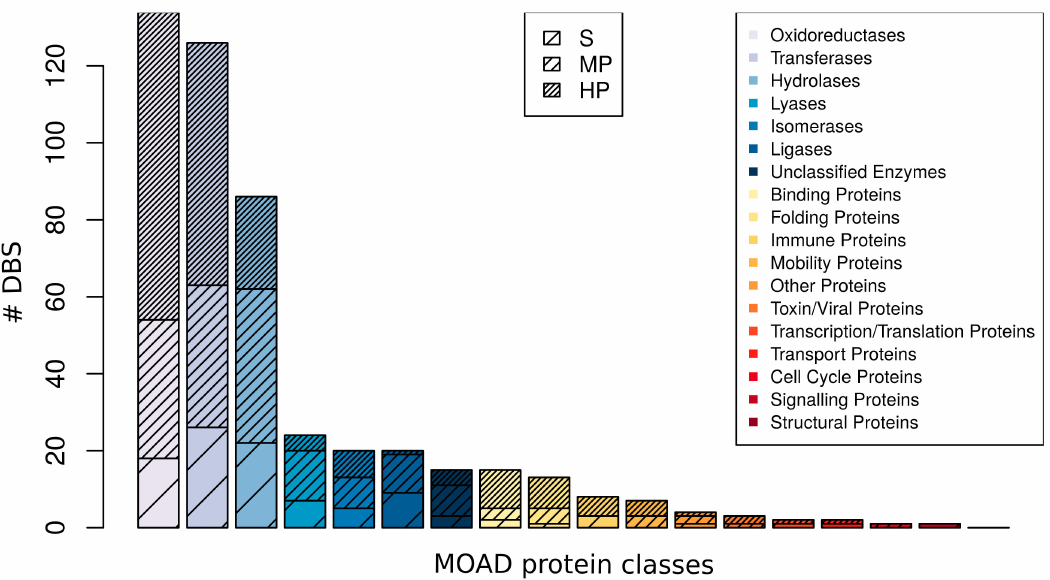
Figure 6. Distribution of the occurrence of DBS observed in the MOAD protein classes and their level of promiscuity in the DBS4 dataset. For instance, the lyase family corresponded to 20 DBS, with 5 S, 8 MP, and 7 HP